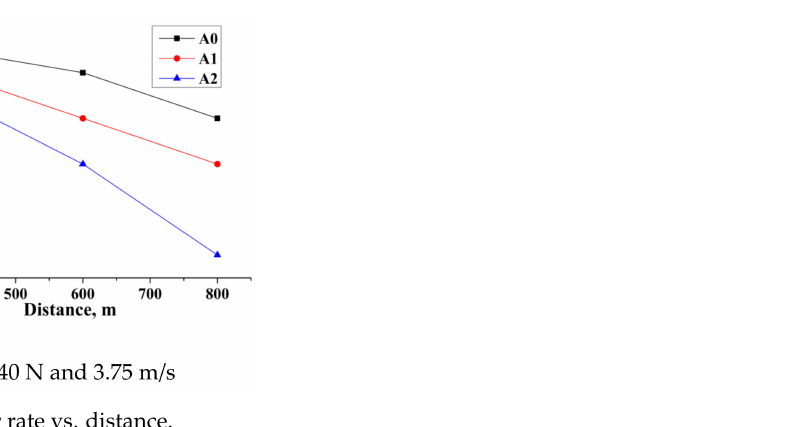
Figure 7. Wear rate vs. distance.